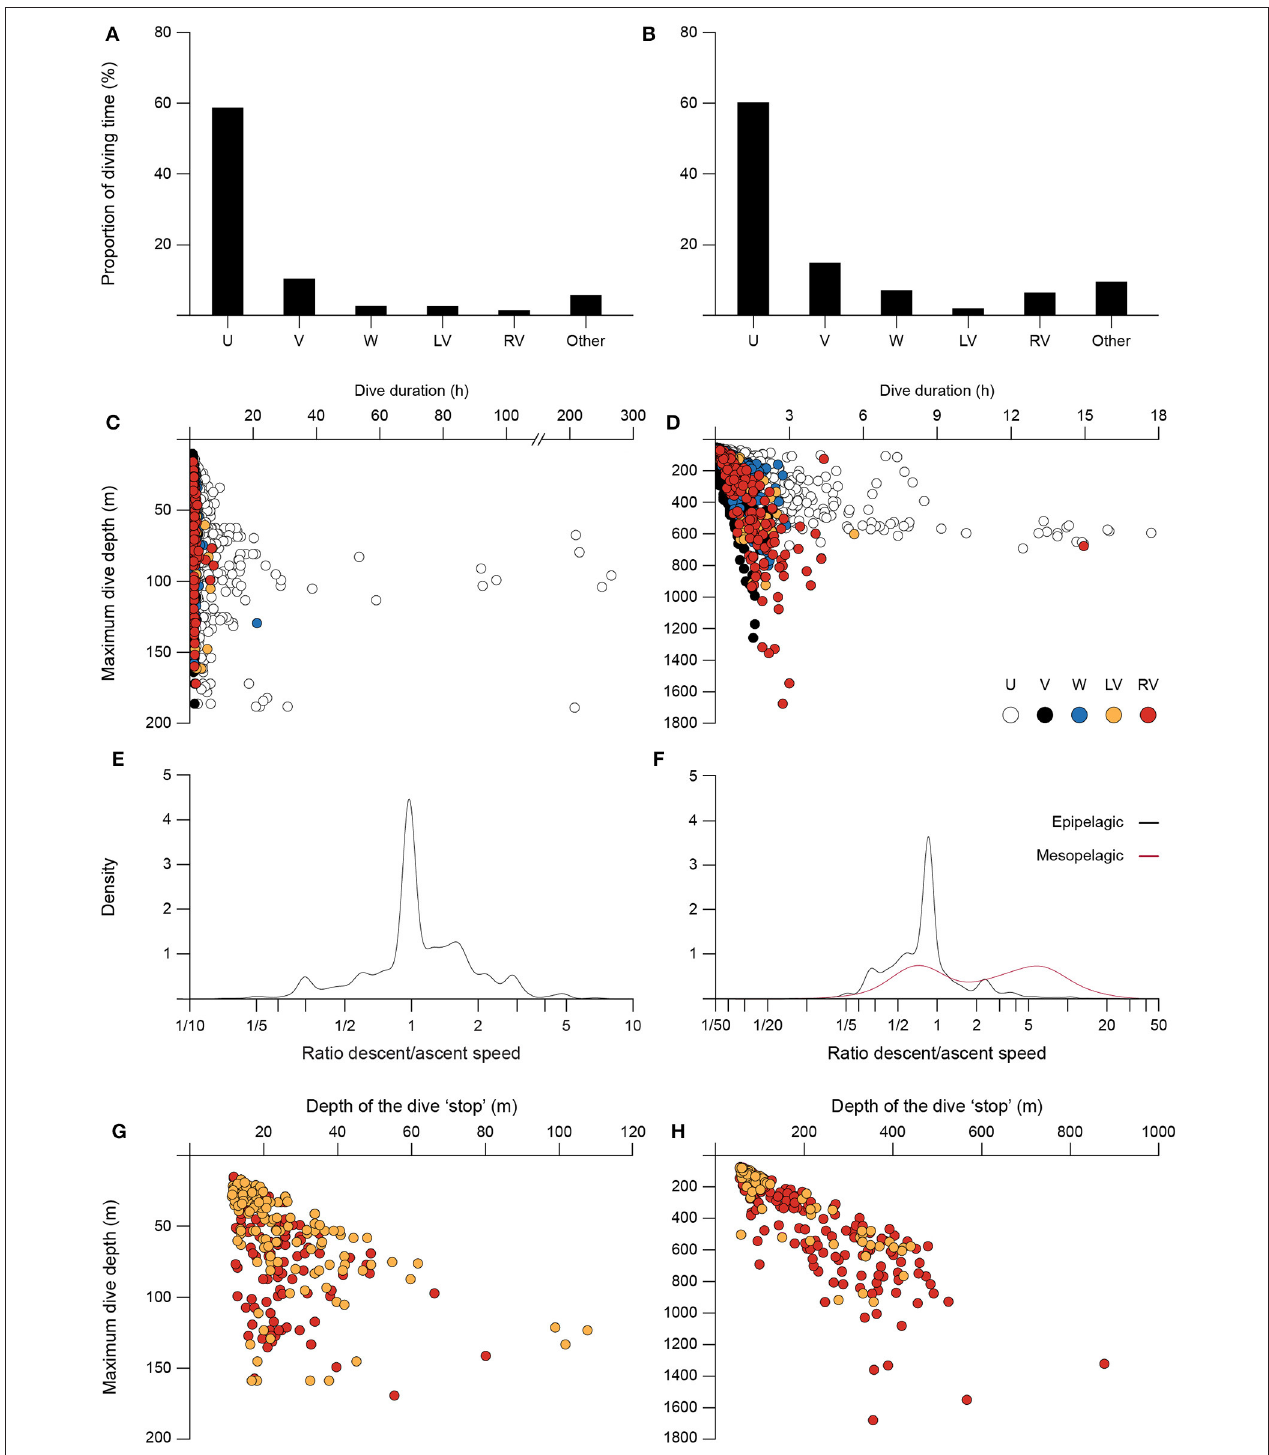
FIGURE 3 | General characteristics of the five dive shape classes, using pooled data of all basking and blue sharks. Basking (A) and blue (B) sharks’ average proportion of diving time spent performing each dive class. Maximum dive depth as a function of total dive duration for basking (C) and blue (D) sharks, color-coded by dive shape (each point corresponds to a single dive). Density distributions of the ratio descent/ascent speed for V-shaped dives of basking (E) and blue (F) sharks; blue sharks epipelagic (0-200 m; black) and mesopelagic ( > 200 m; red) dives are represented as separate groups. Maximum dive depth as a function of mean depth of the “stop” phase for LV- and RV-shaped dives of basking (G) and blue (H) sharks (each point corresponds to a single dive).